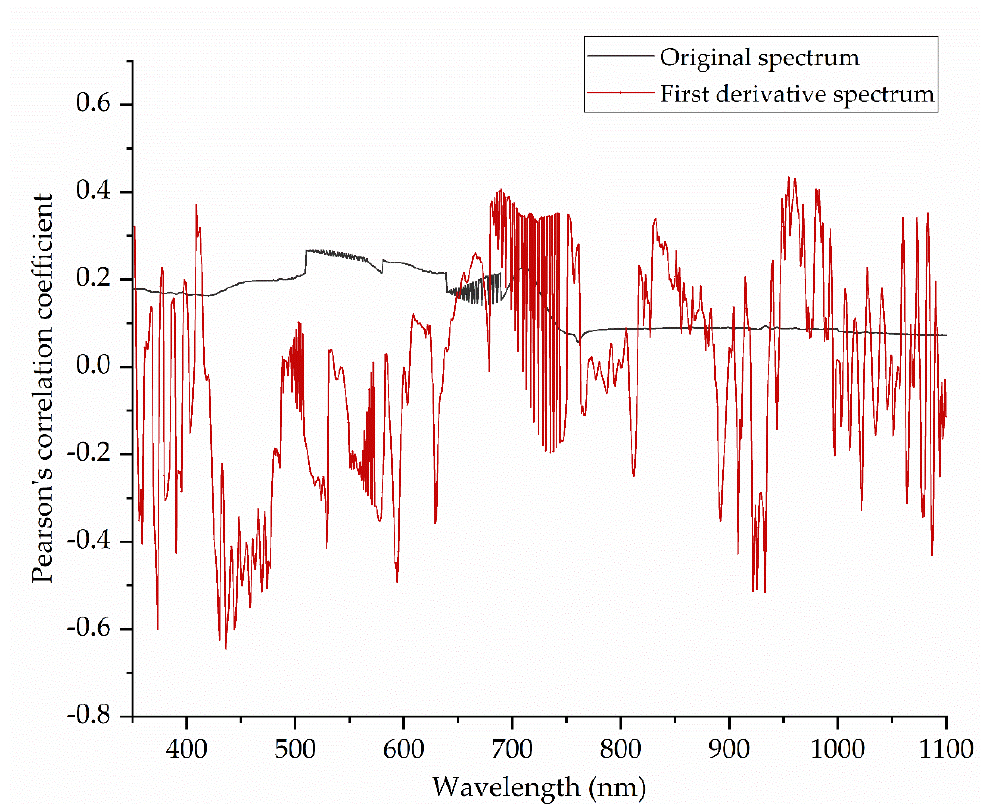
Figure 7. Correlation analysis and comparison of leaf spectrum, first derivative spectrum data and CCI value of relative chlorophyll content of Quercus aquifolioides.